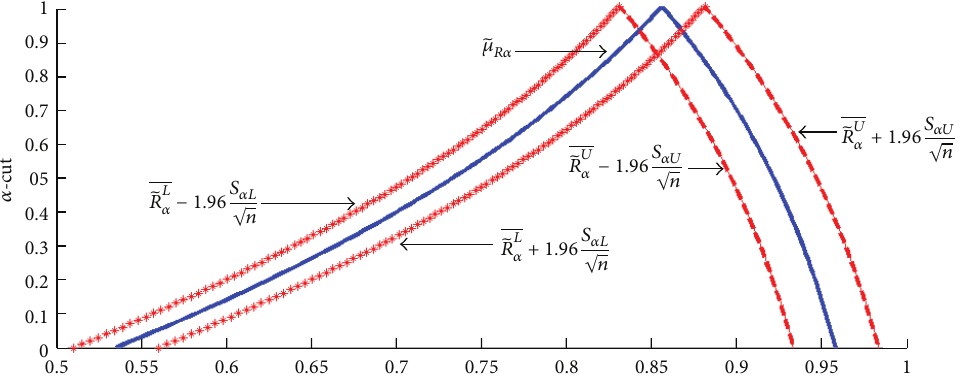
Figure 6: Fuzzy 95% confidence intervals for fuzzy parameter ̃𝜇 𝑅𝛼 = [(̃𝜇 𝑅 ) 𝐿 𝛼 ,(̃𝜇 𝑅 ) 𝑈 𝛼 ]